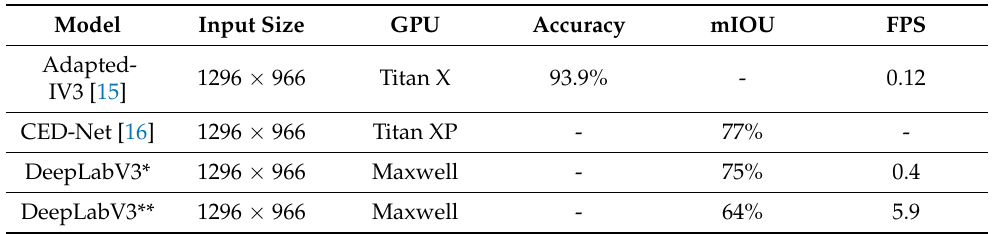
Table 12. Comparison of the segmentation performance of other works on the CWFID test dataset.